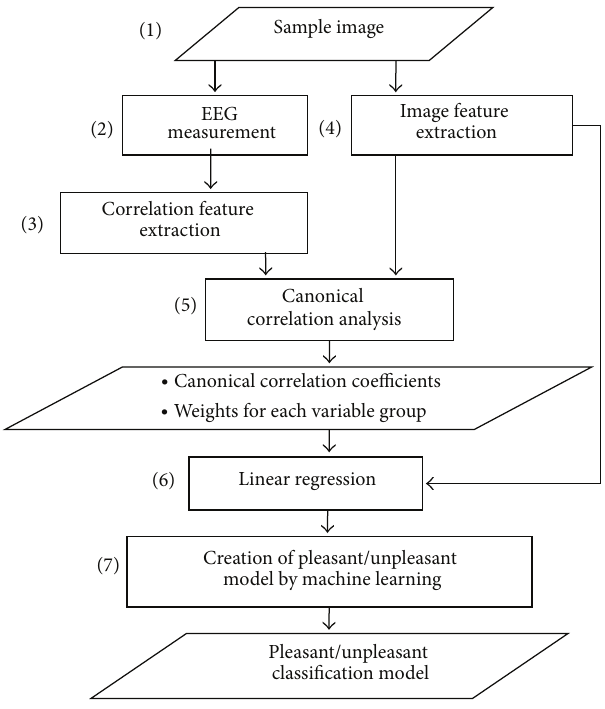
Figure 1: Flow of the proposed method.